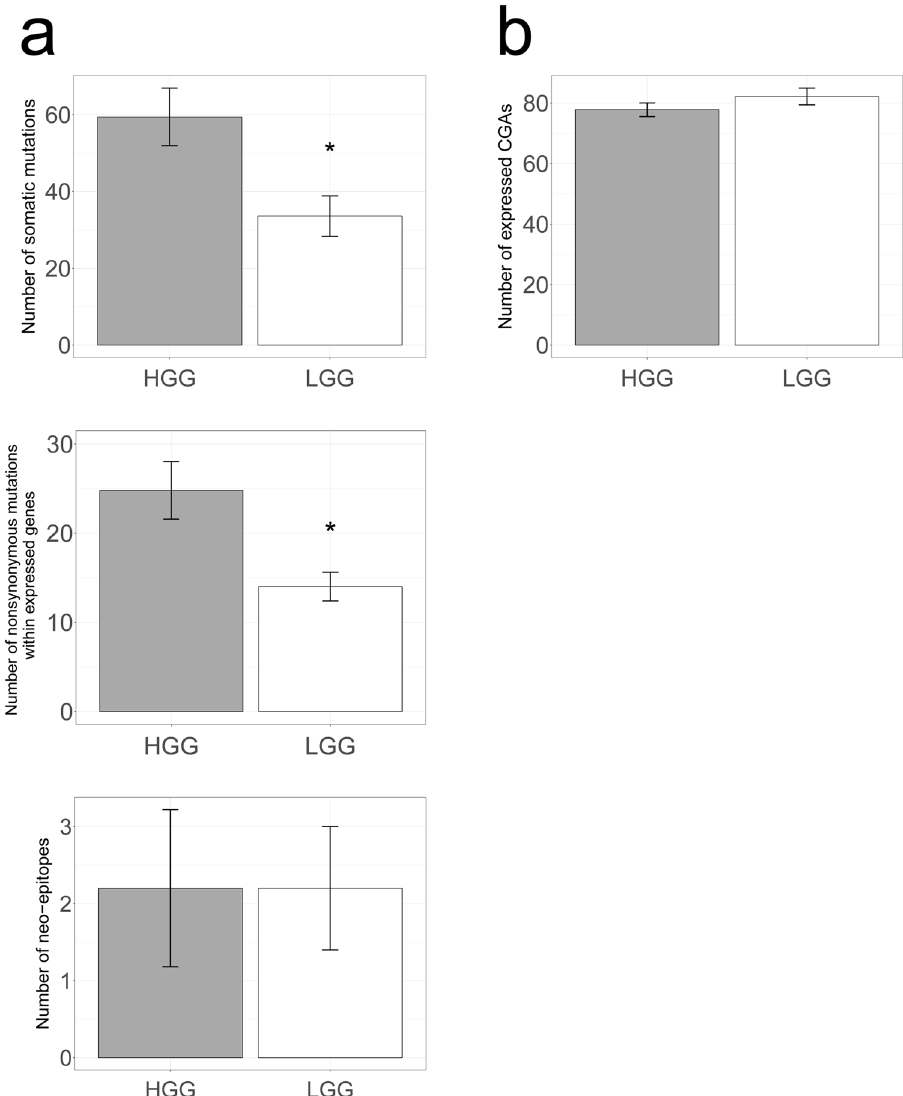
See materials and methods for details. ( b ) Number of expressed CGAs was similar in LGG and HGG samples. Mann-Whitney U test. * P <